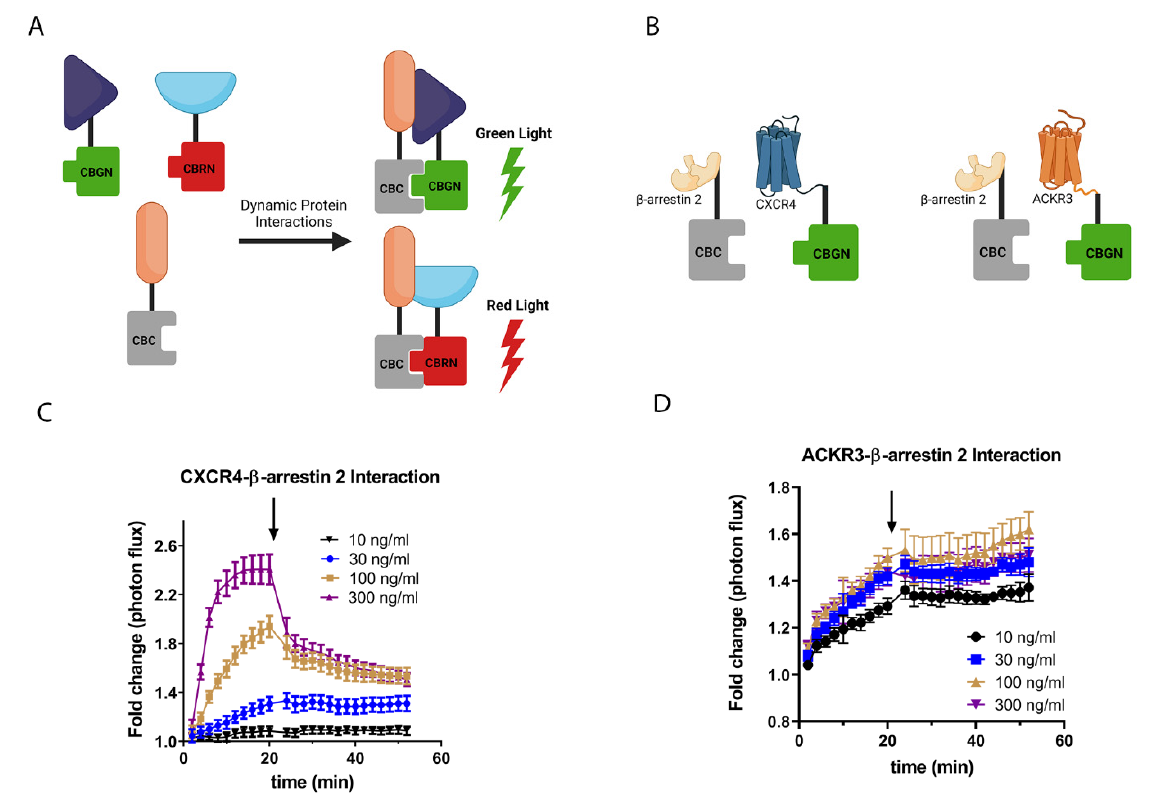
Figure 1. Differing kinetics of CXCL12 ‐ mediated recruitment and dissociation of β‐ arrestin 2 from CXCR4 and ACKR3. ( A ) Schematic of dual ‐ color click beetle luciferase complementation system. We fused proteins of interest to N ‐ terminal fragments of click beetle green (CBGN) or click beetle red (CBRN) luciferases or the common C ‐ terminal fragment (CBC). Interactions between proteins of interest bring N ‐ and C ‐ terminal fragments together to produce light, with the N ‐ terminal fragment determining the wavelength. We discriminated between green and red bioluminescence with optical filters. ( B ) Schematic of complementation pairs to detect association of CXCR4 or ACKR3 with β‐ arrestin 2 panels ( C,D ), respectively. ( C ) We treated MDA ‐ MB ‐ 231 cells stably expressing CXCR4 ‐ CBGN ( C ) or ACKR3 ‐ CBGN ( D ) and β‐ arrestin 2 ‐ CBC with increasing concentrations of CXCL12 ‐α . After 20 min of imaging, we washed cells to remove medium with ± SEM for fold change in bioluminescence relative to cells treated with vehicle only. Illustrations